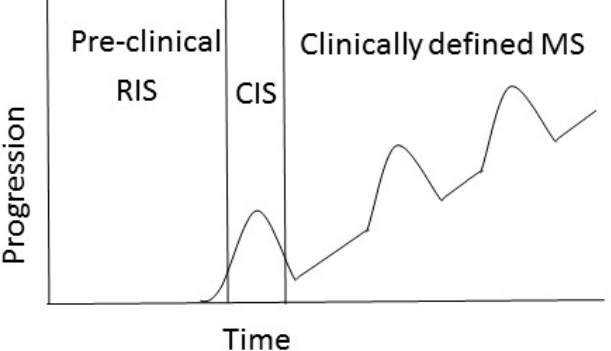
Figure 2. Clinical course of MS. The course of MS can be divided into clinically isolated syndrome (CIS) and clinically defined RPMS. Radiologically isolated syndrome (RIS) is defined by incidental imaging findings suggesting inflammatory demyelination in the absence of clinical signs or symptoms, while CIS is identified as the first clinical presentation of the disease. SPMS is diagnosed retrospectively by a history of gradual worsening after an initial relapsing disease course